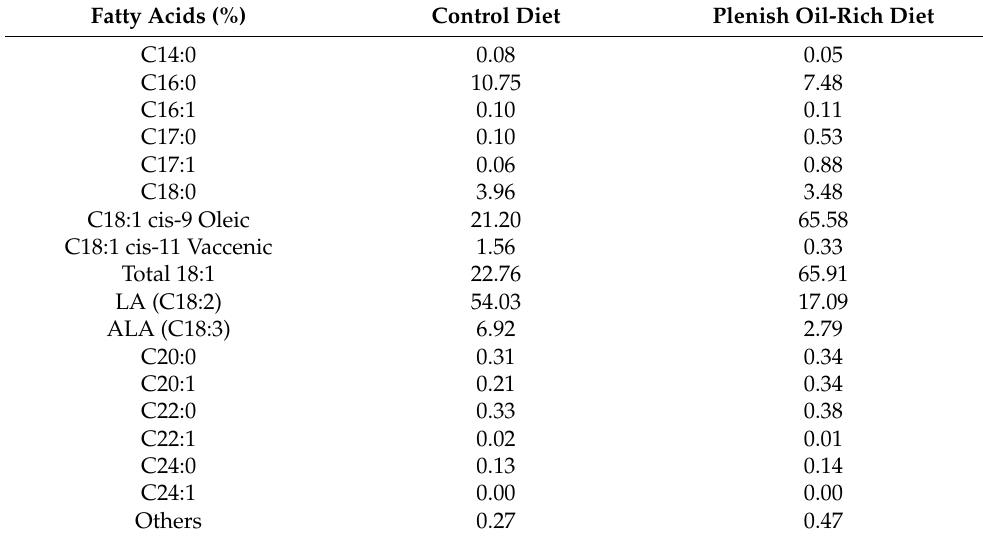
Table 2. Fatty acid profile of the experimental